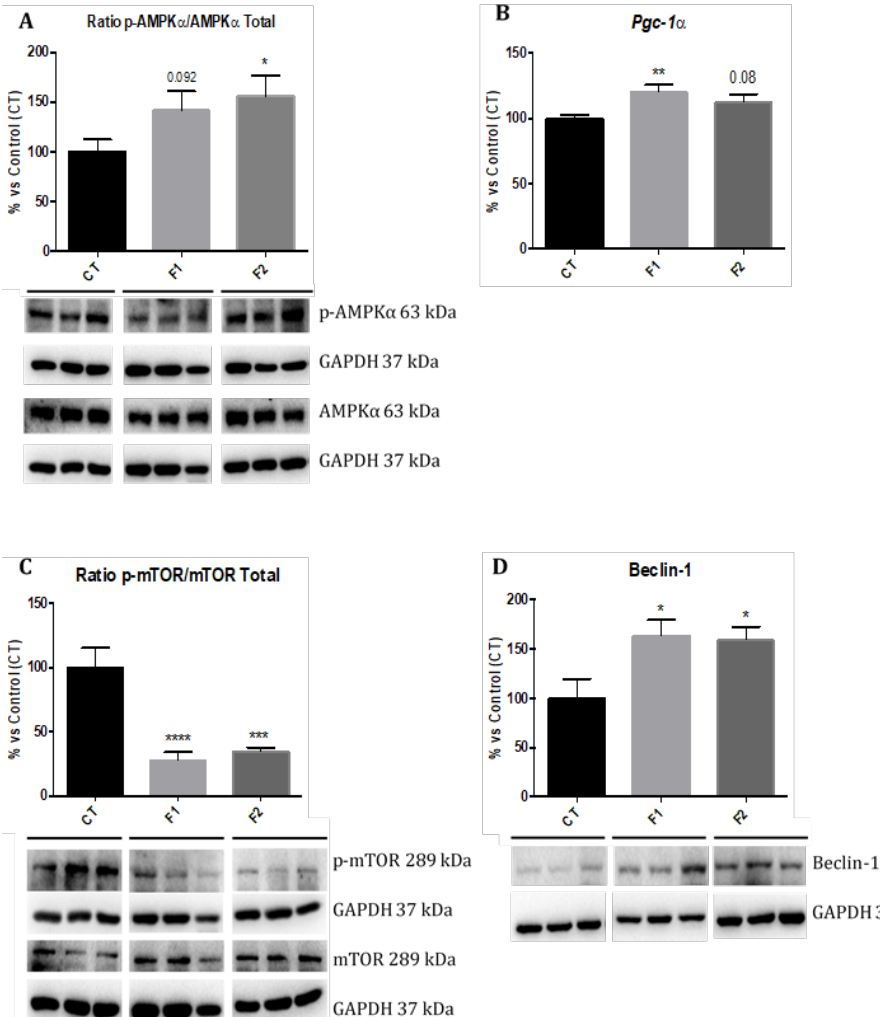
Figure 5. AMPK/mTOR signaling cascade in the hippocampus of females and males at 6 months of age for all mice groups. Representative Western blot for ratio p-AMPK/AMPK, ratio p-mTOR/mTOR, Total and Beclin-1 protein levels, and their respective quantification ( A , C , D ). Values in bar graphs are adjusted to 100% for protein levels of the CT group. Representative gene expression for Pgc-1α ( B ). Gene expression levels were measured by real-time PCR from hippocampal mRNA. Values are mean ± SEM; n = 18 (CT n = 6, F1 n = 6, F2 n = 6 for each group, females n = 3, males n = 3). Statistics: *** p < 0.001; **** p < 0.0001.